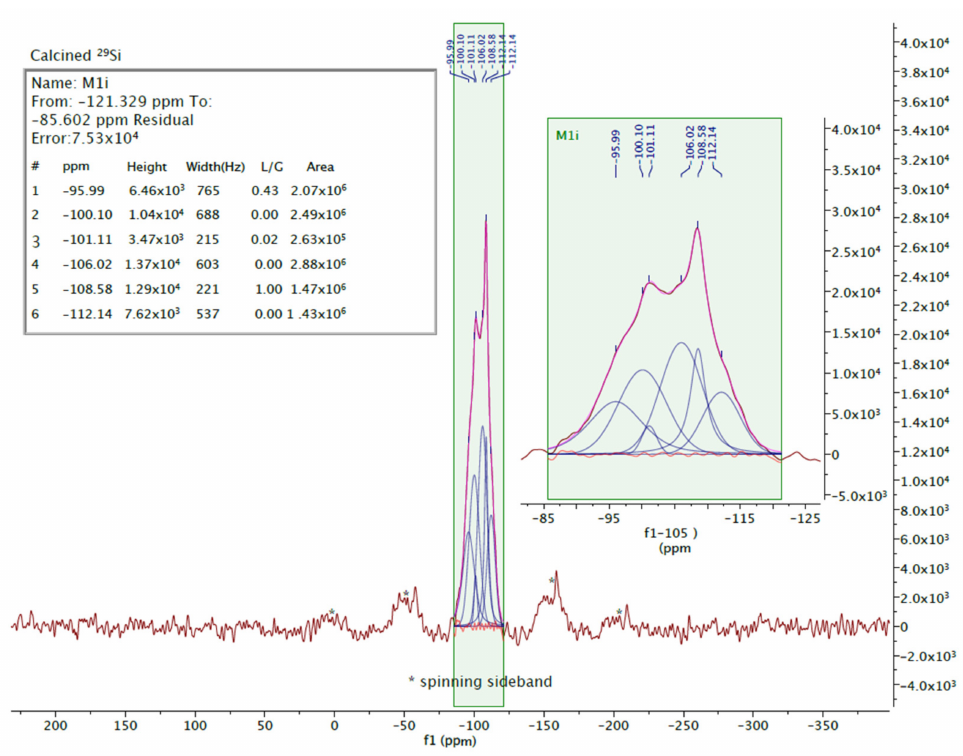
Figure 11. The 29Si NMR spectrum of calcined NV-Na referenced externally to a sample of talc at − 98.1 ppm relative to tetramethylsilane (TMS) at 0 ppm. The shaded inset depicts the obtained resonances on top and the deconvoluted components of the fit